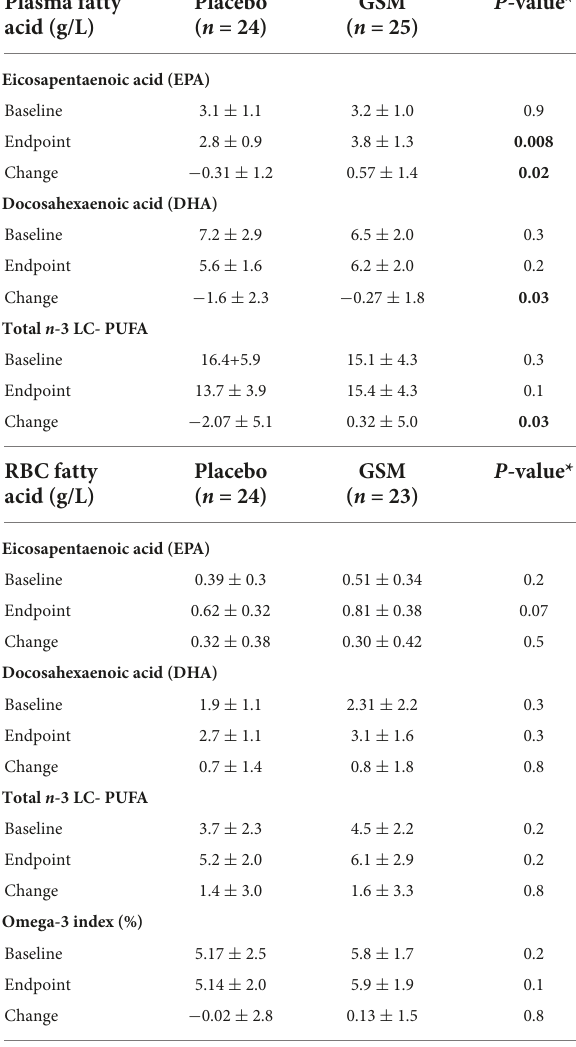
TABLE 4 Correlation between urinary C-telopeptide of type II collagen (CTX-II), serum cartilage oligomeric matrix protein (COMP), and plasma 25(OH)D with visual analogue scale (VAS) pain and knee injury and osteoarthritis outcome score (KOOS) domain scores at baseline ( n = 49).